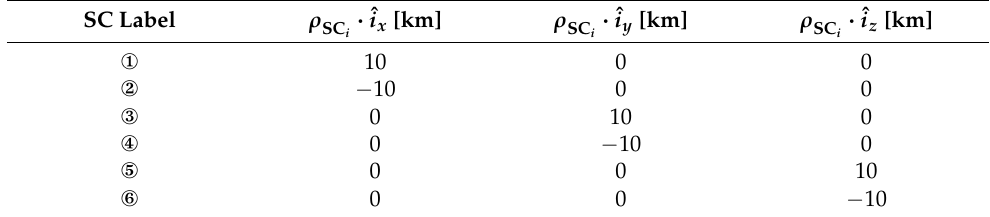
Figure 8. Test case formation structure in rotating reference frame T H . Table 1. Position vector components of the formation elements in the test case inspection